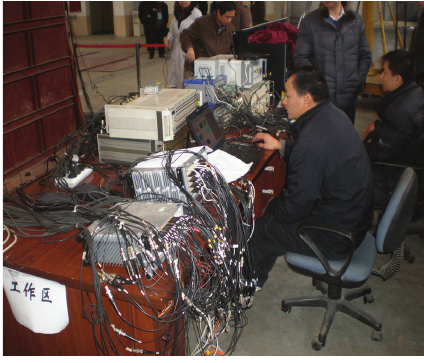
Figure 1: Systems of CNC, data acquisition, and analysis.